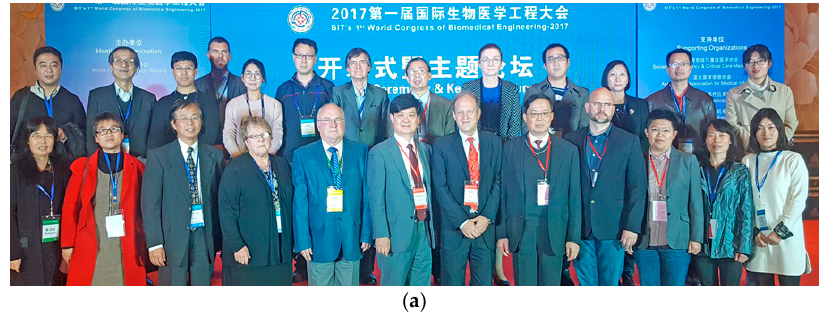
Hilton, Xi’an, China, 380 participants, Report published in Medicines [10].